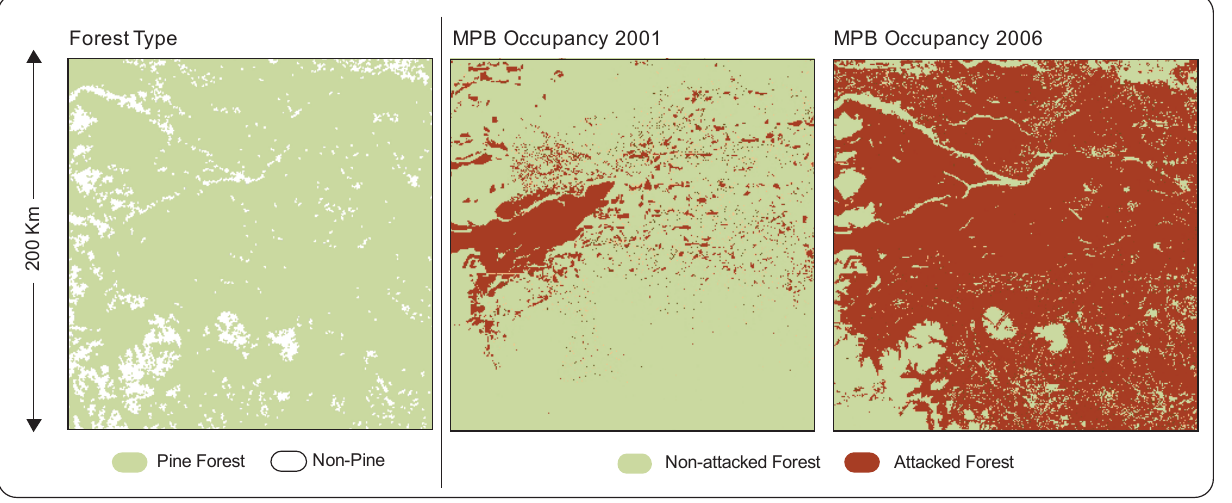
Figure 2. Mountain pine beetle (MPB) occupancy in study site in 2000 and 2005 based on aerial overview survey data acquired in 2001 and